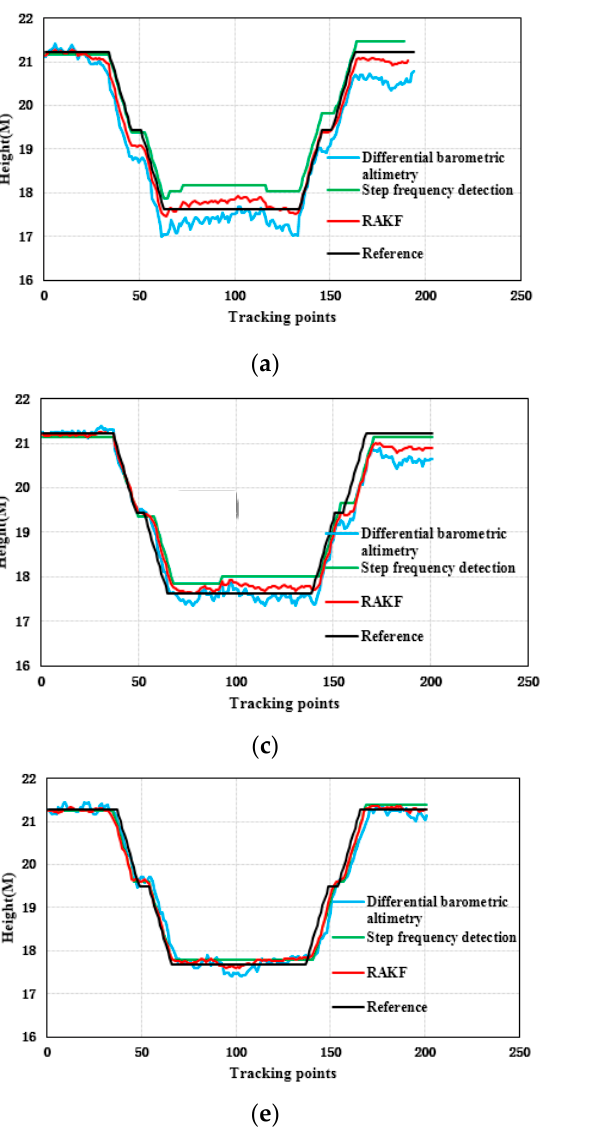
Sensors 2021 , 21 , x FOR PEER REVIEW